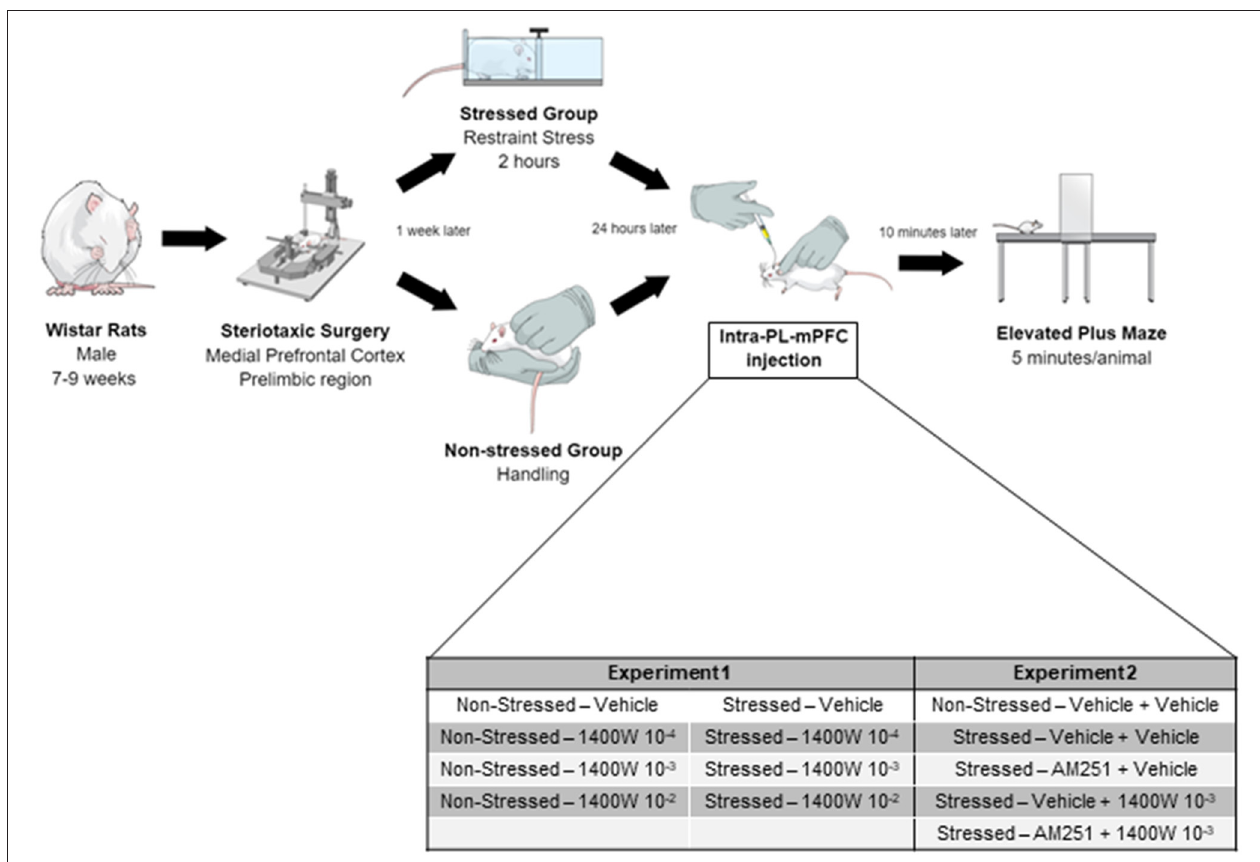
FIGURE 1 | Timeline of all procedures performed. Stereotaxic surgery was performed to cannulae implantation into the PL-mPFC of all animals. After 1 week, the stressed groups were submitted to 2h of restraint stress. The following morning, the animals received the intra-PL-mPFC injections and, after 10 min, were tested in the EPM. In experiment 2, the second injection was performed 5min after the first one.